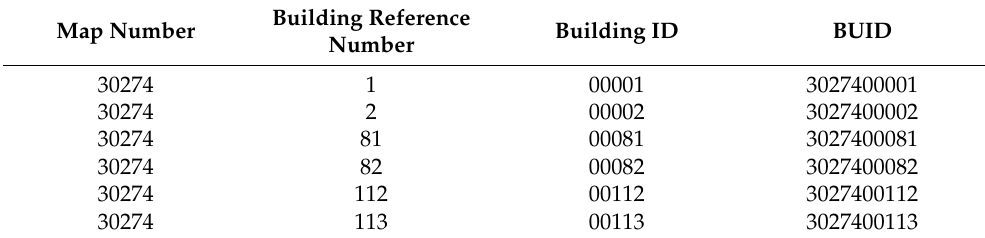
Table 1. Creation of Building Unique ID.